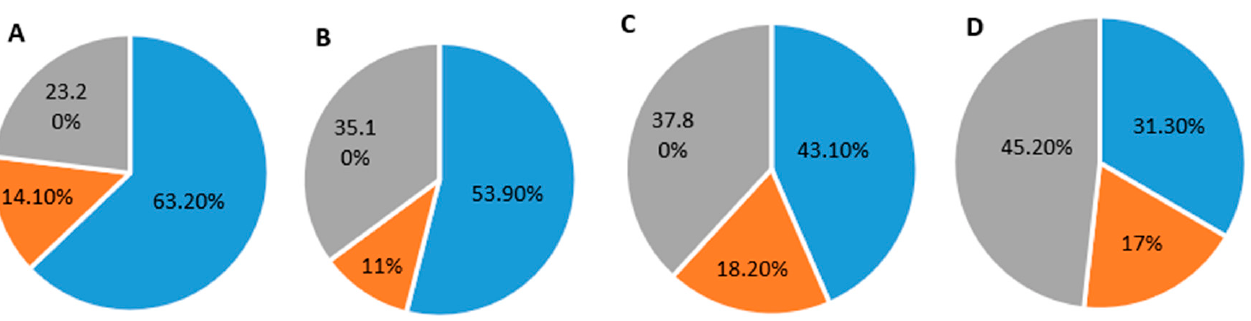
Figure 8. Percentage of cells in different phases of the cell cycle in MCF-7 cells and MDA-MB-231 cells. ( A , B ) Cells treated with 1 µ M Dox and Cells treated with 1 µ M Dox-loaded in ABN-SPDP in MCF-7 cells. ( C , D ) Cells treated with 1 µ M Dox and Cells treated with 1 µ M Dox-loaded in ABN-SPDP in MDA-MB-231 cells. Blue: cells in G0/G1 phase; orange: cells in S phase; grey: cells in G2/M phase.